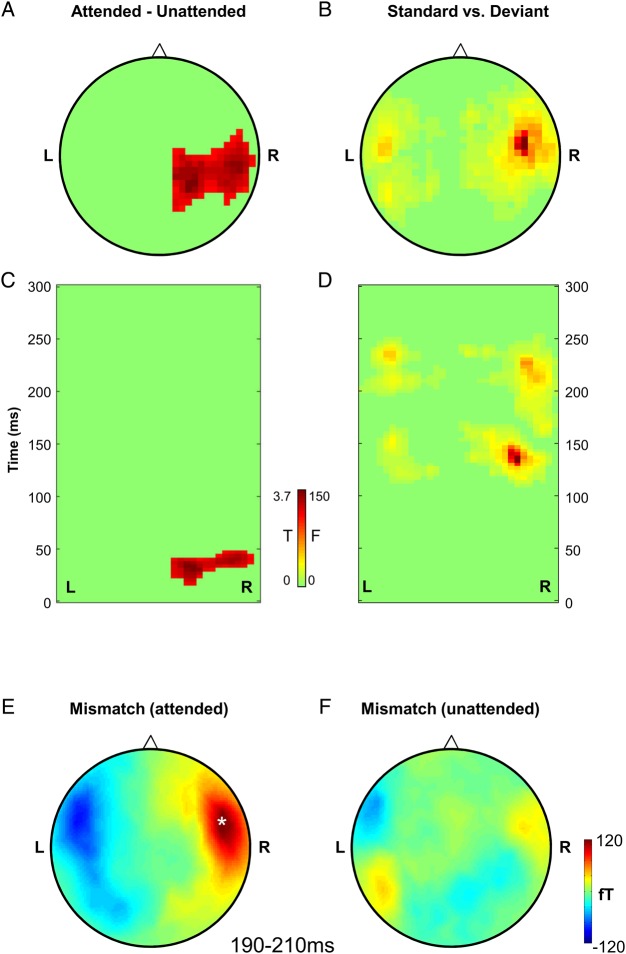
Effects of attention (top row) and expectation (bottom row) on ERF amplitude. (A–D) Left column: the topography of significant effects; the main effect of attention thresholded at T = 2.68 (P < 0.005 peak-level, corrected for multiple comparisons at a cluster-level pFWE < 0.05); the main effect of expectation thresholded at F = 10.34 (P < 0.005 peak-level, corrected for multiple comparisons at a cluster-level pFWE < 0.05). Right column: the timing of the significant effects (same thresholding as for the topography plots; x-axis: left-right topography, y-axis : peristimulus time). (E,F) Topography of the mismatch response (auditory standards vs. deviants) for the attended (left) and unattended (right) conditions. Plots show ERF amplitude averaged over 190–210 ms post-stimulus, corresponding to the timing of a significant interaction between attention and expectation (P < 0.005 peak-level, corrected for multiple comparisons at a cluster-level pFWE < 0.05). Asterisk indicates the topography of the significant interaction cluster. Post-hoc paired t-tests revealed that ERF amplitude over right fronto-temporal channels was significantly different between standards and deviants for the attended condition, but not for the unattended condition.